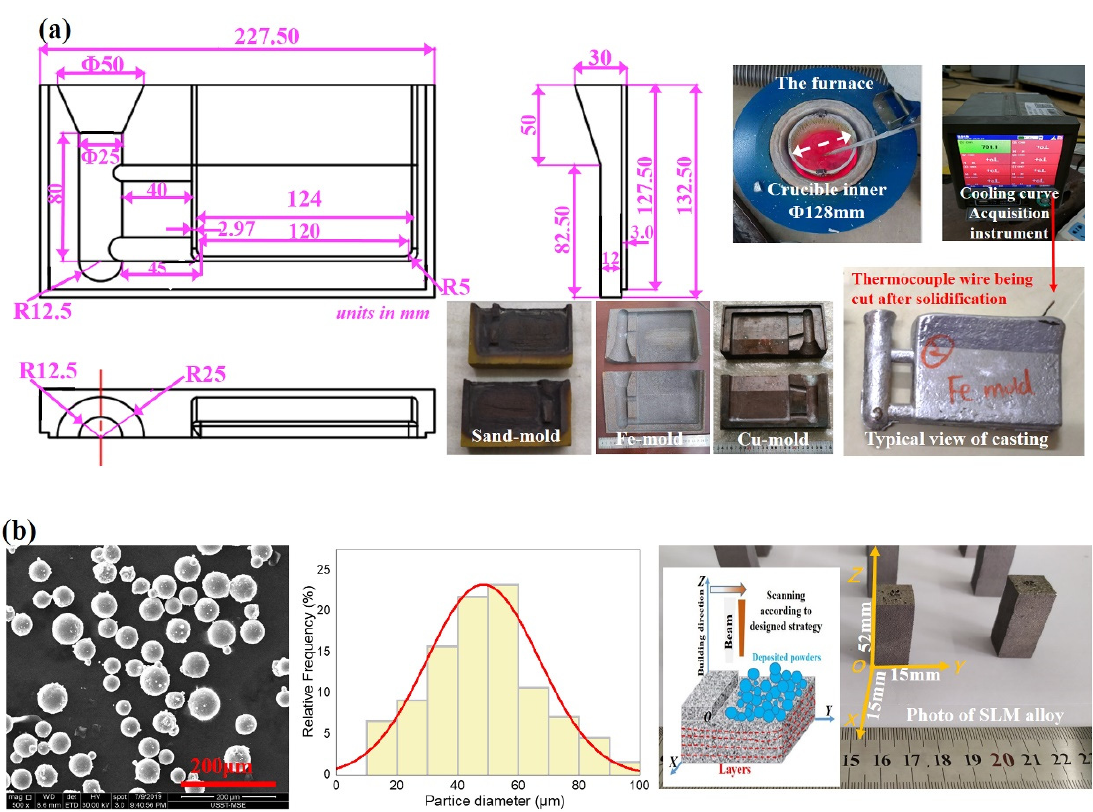
Figure 1. Alloy preparation details. ( a ) Conventional casting process using crucible electrical furnace and the alloy melt was poured into sand, Fe or Cu mold with the same dimensions (in mm); ( b ) SEM and particle distribution of Al10SiMg raw powder used for selective laser melting (SLM) and the photo of as-built samples.